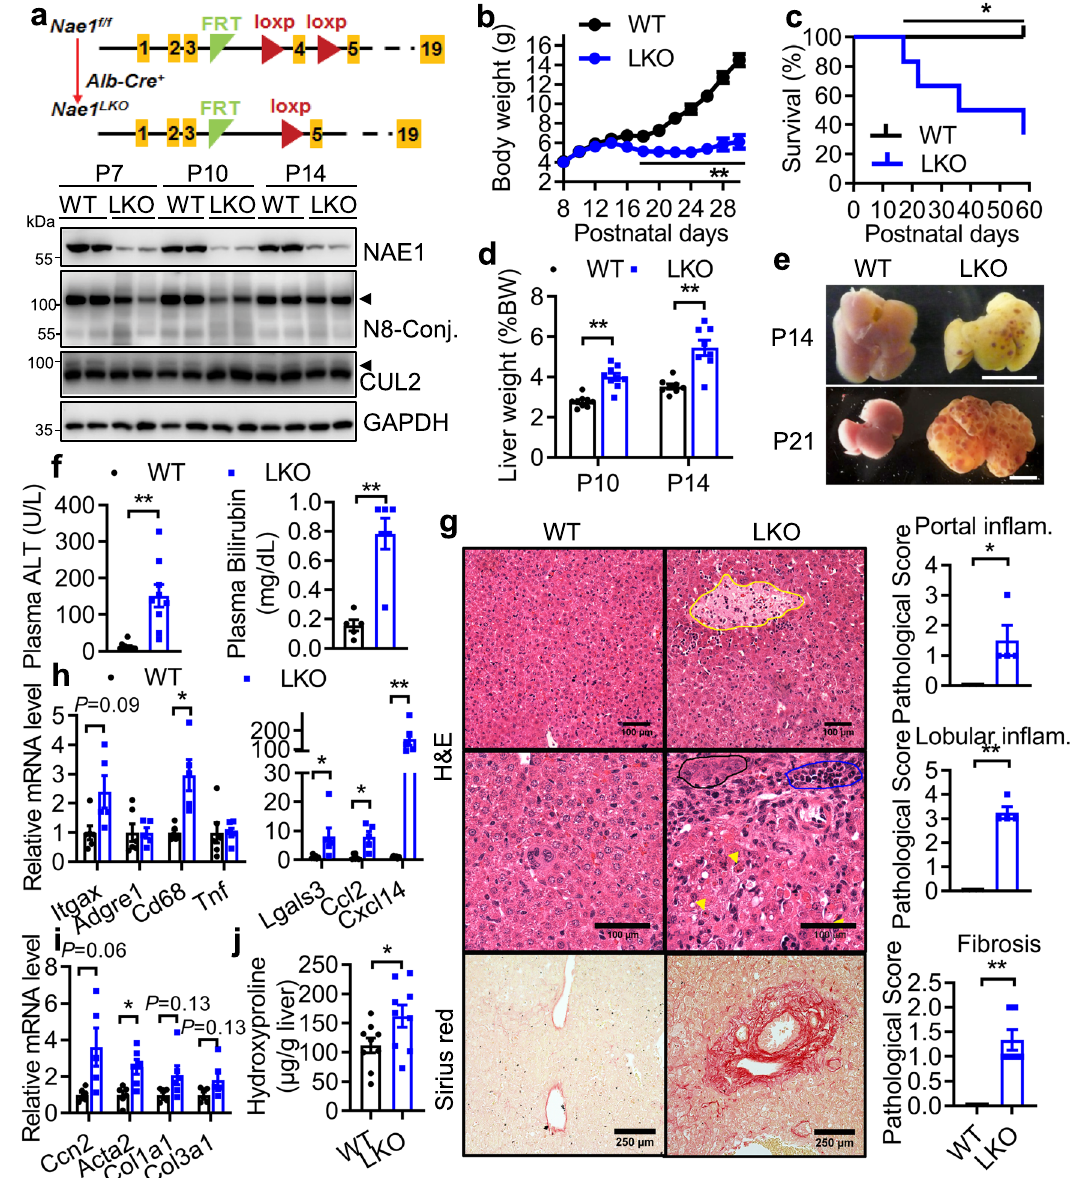
Fig. 1 | Embryonic-onset, hepatocyte-speci fi c deletion of NAE1 causes liver failure and premature death. a Schematic diagram depicting the generation of Nae1 f/f ; Alb-Cre +(LKO) mice with embryonic-onset hepatocyte-speci fi c deletion of NAE1 by crossing Alb-Cre +mice with Nae1 fl oxed ( Nae1 f/f ) mice. Nae1 f/f mice served as wild-type (WT) controls. Western blot of NAE1 and neddylated conjugates (N8- Conj.)inliverextractsofWTandLKOmiceatP7,P10,andP14Arrowheadindicates neddylated CULs and CUL2. Two independent experiments. b BW of WT and LKO mice till postnatal 30days ( n =6 per group). ** P <0.005. c Survival curves of WT and LKO mice ( n =6 per group). Log-rank (Mantel-Cox) test. * P =0.0183. d Liver weight as normalized to BW at P10 (WT: n =9; LKO: n =9, ** P =0.000043) and P14 (WT: n =8;LKO: n =8,** P =0.000275). e GrossmorphologyofliversatP14andP21. Scale bar: 25mm. f Plasma ALT (WT: n =10; LKO: n =9, ** P =0.0002) and bilirubin (WT: n =5; LKO: n =6, ** P =0.0006) levels of WT and LKO mice at P14. g H&E and